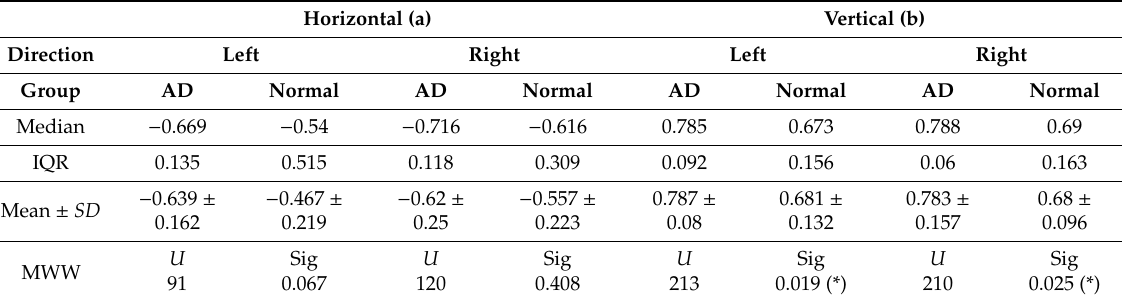
Table 2. Results of Spearman’s